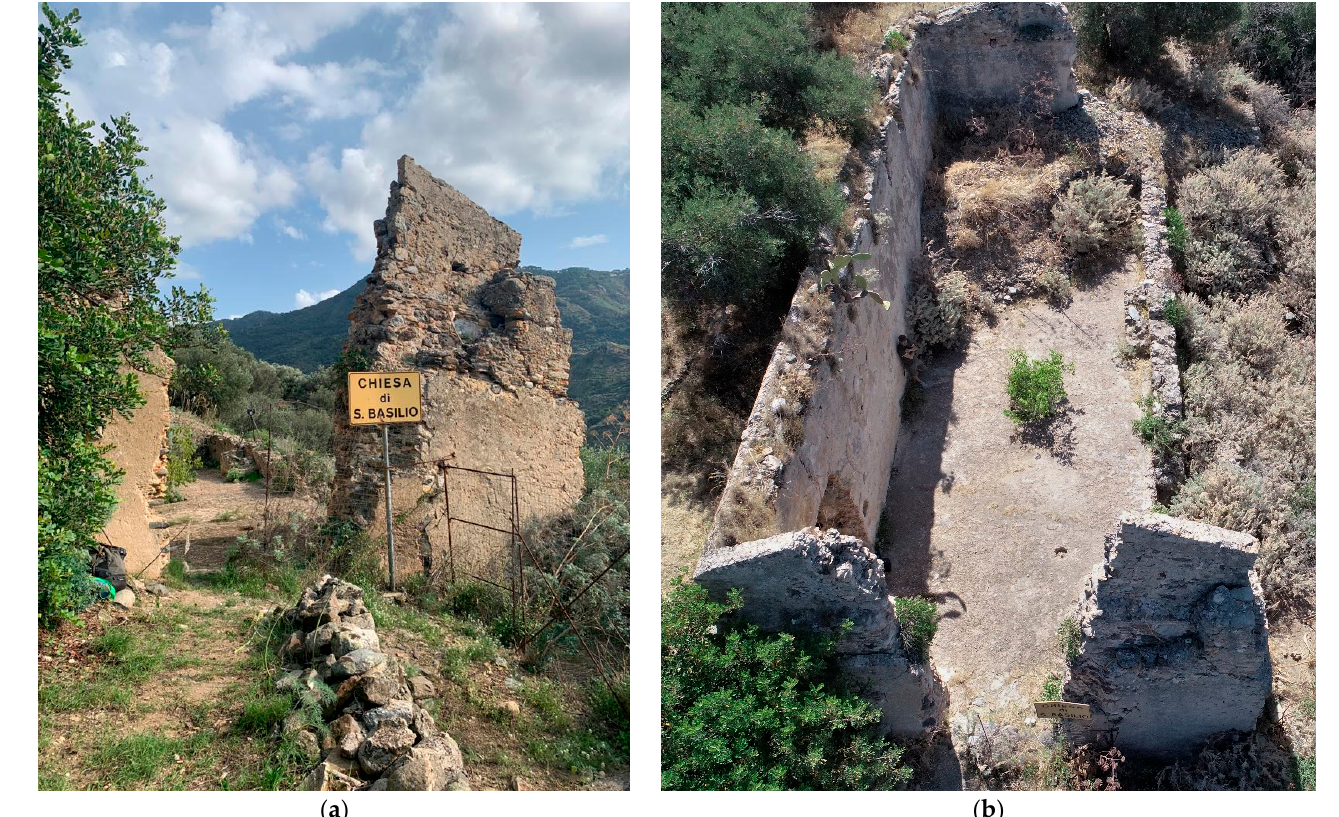
Figure 6. The Church of San Basilio: ( a ) Ruins of the main façade; ( b ) Aerial view from the west.